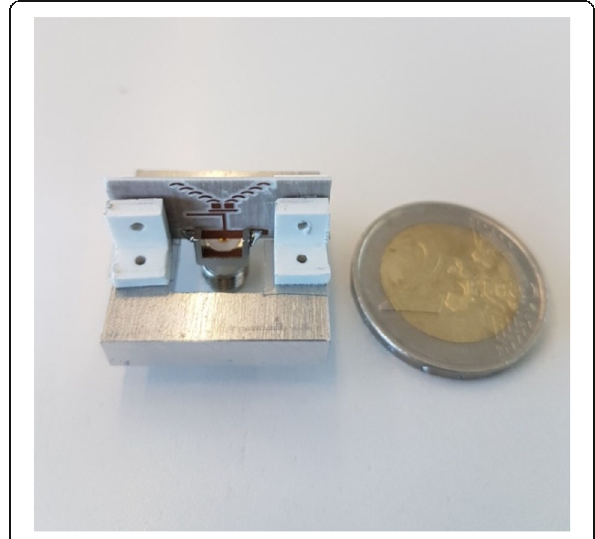
Fig. 21 Fabricated prototype with size of a square centimetre and the supporting